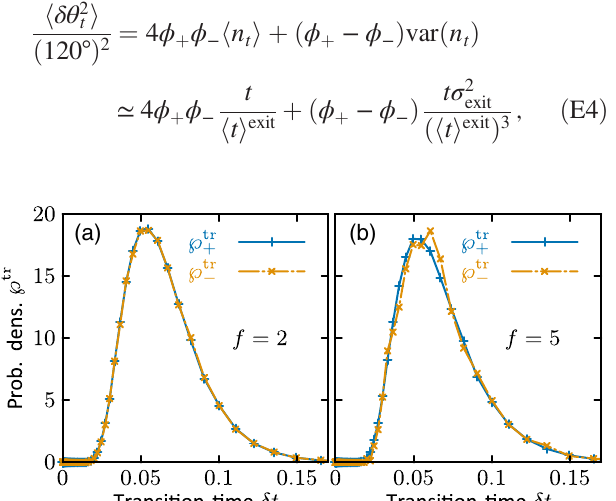
FIG. 21. Test of forward and backward symmetry of transition time. Probability density of transition time ℘ tr in forward þ and (cid:5) backward − direction for weakly (a) f ¼ 2 and (b) f ¼ 5 . The number of trajectories entering ℘ tr − are (a) n − ¼ 59745 and (b) n − ¼ 3327 (see also Table VII). Deviations between blue and orange lines in (b) are due to finite statistics ( n − ¼ 3327 ); see also Table VII for the number of observed